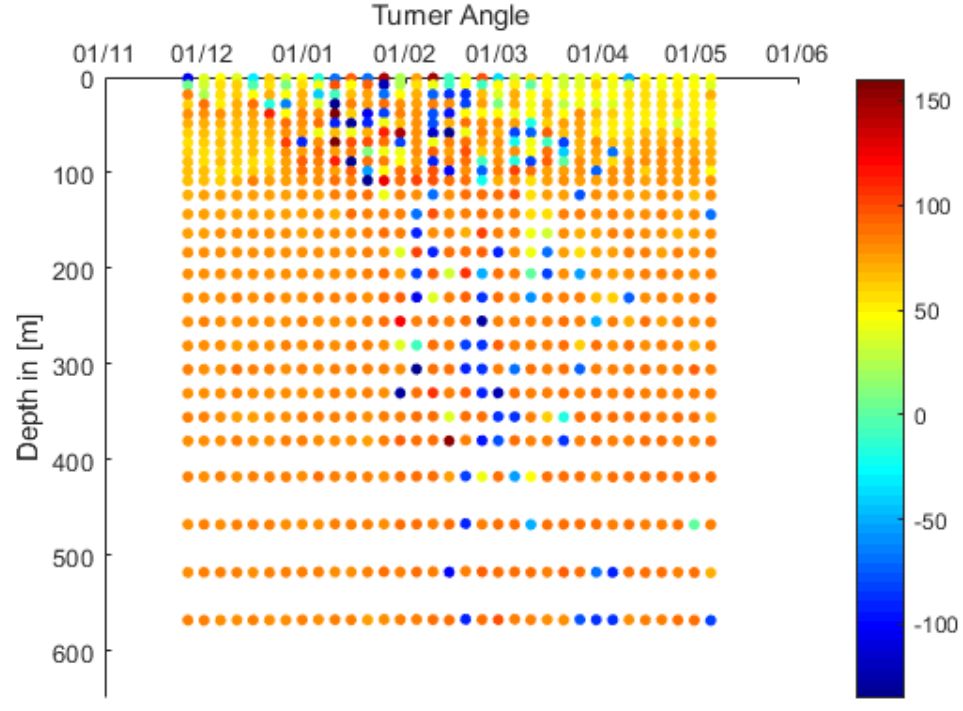
Figure 7. The Turner angle (°) of float WMO 6900098 describes the contribution of salinity and temperature gradients to the density gradient.